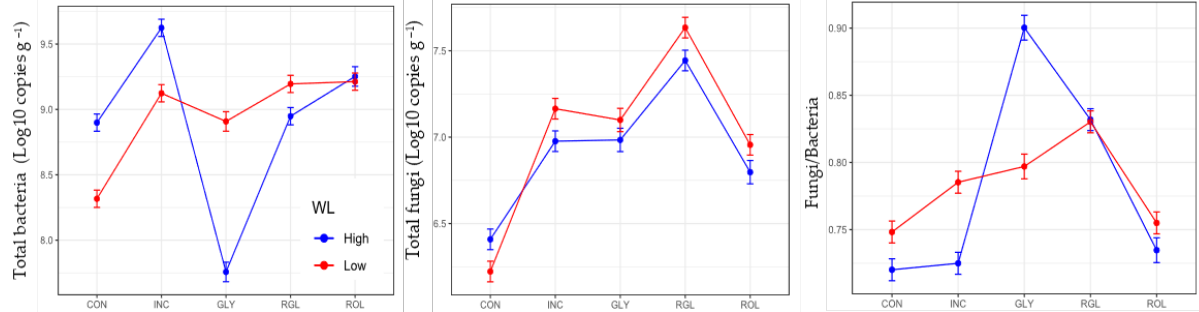
Figure 1. Total bacteria, total fungi, and ratio Fungi/Bacteria at maize pre-emergence for the termination methods: control (CON), mowing + incorporation (INC), glyphosate (GLY), glyphosate + roller (RGL), and roller crimper (ROL), under two water levels. Bars represent 95% confidence intervals according to Tukey’s HSD method.